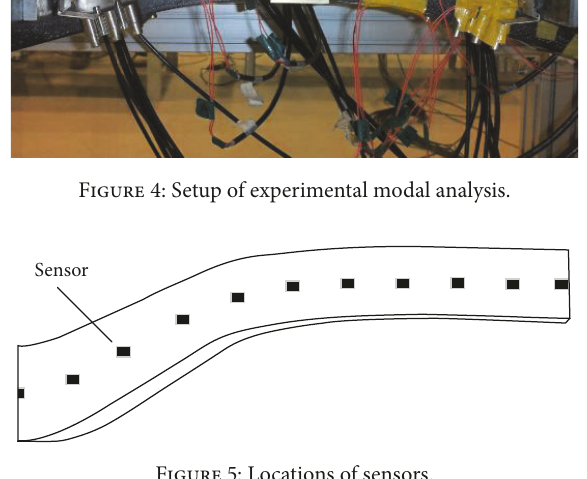
Figure 5: Locations of sensors.